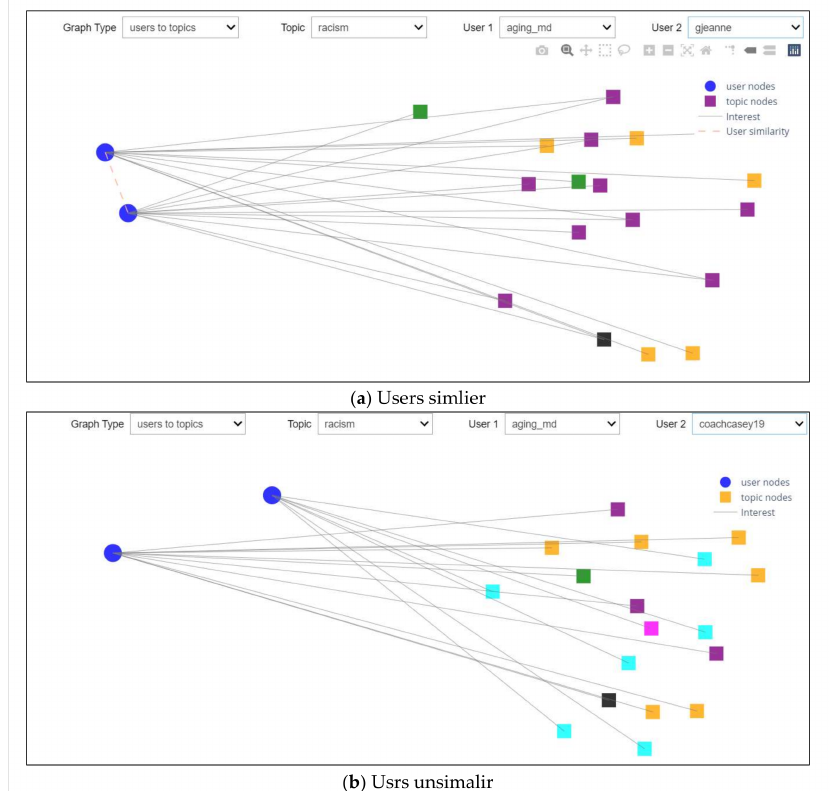
Figure 16. Relationships between Users